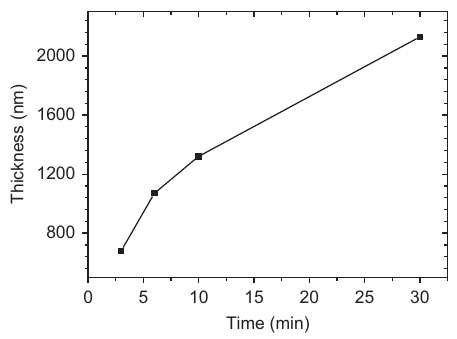
Figure 3 Thickness of zeolite layer vs. synthesis time in zeolite coatings on silicon wafer with a silicon oxide layer. Synthesis tem- perature = 453 K. Maximum microwave power = 500